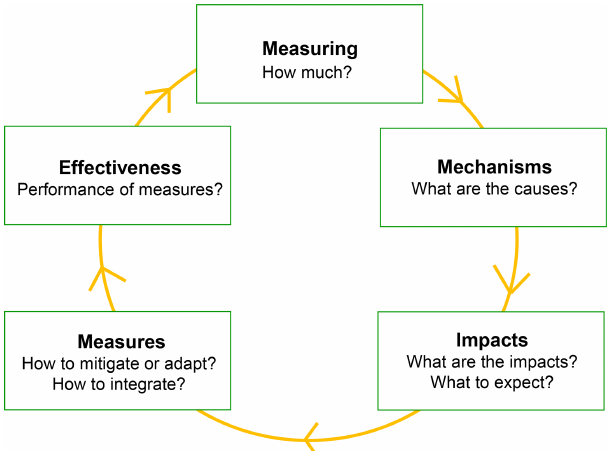
Figure 2. The program framework and approach link up with the policy cycle to ensure uptake of the research results in policy and to facilitate implementation of effective measures (after: Erkens and Stouthamer,